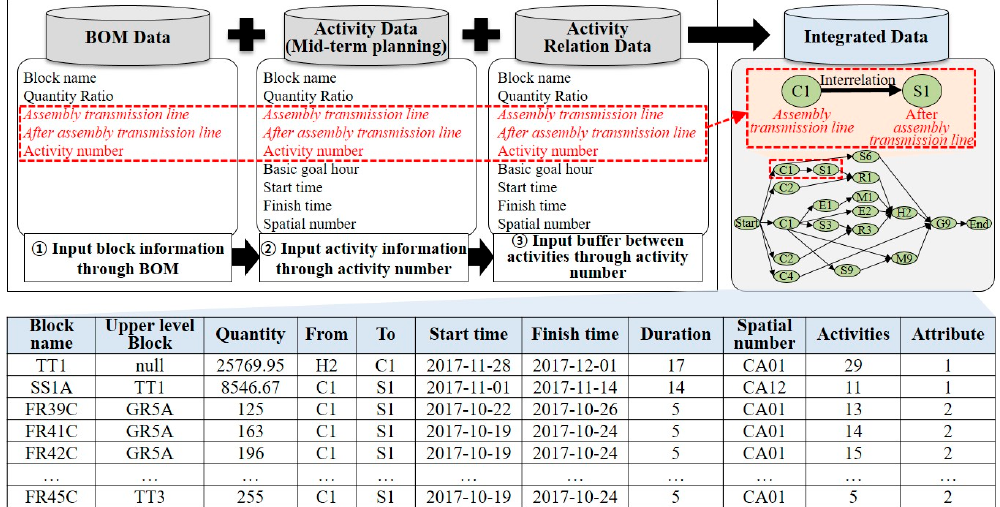
Figure 6. Creation of integrated data through the relationships between the BOM, activities, and activity relationships data.